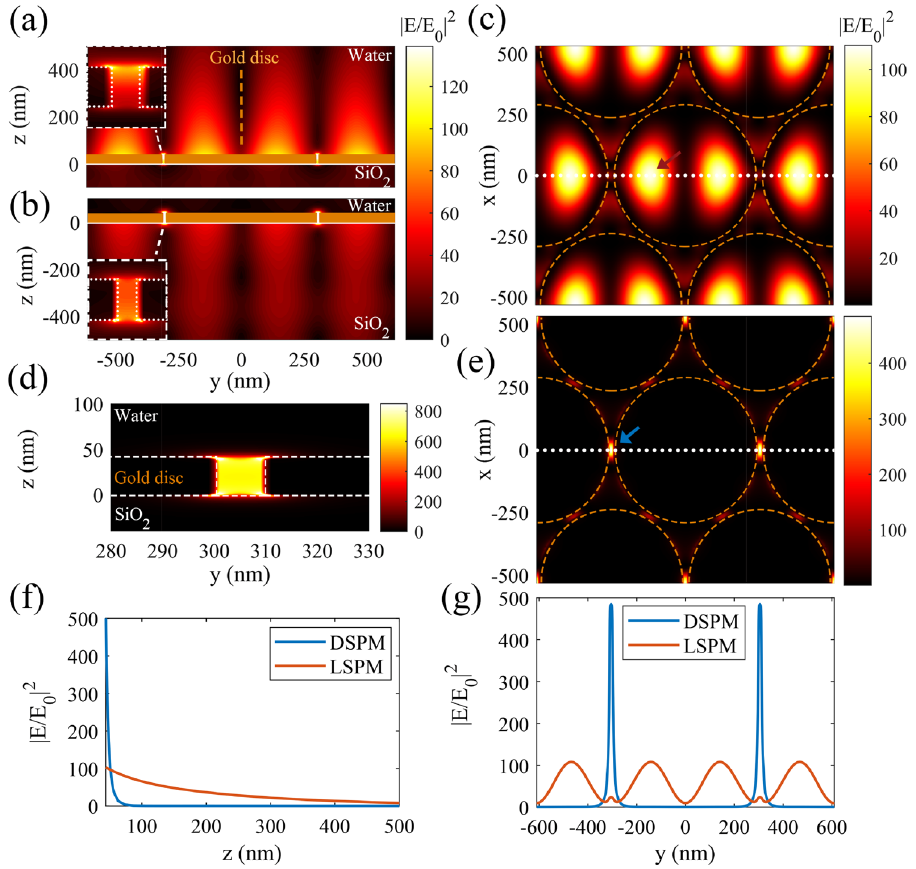
Figure 5. ( a , b ) The cross section views of the field intensity distribution for LSPMs, corresponding to peaks (ii) and (iii) of the red dotted spectrum in Fig. 3b. ( c ) The top view (at z = 50 nm) of the normalized field intensity distribution corresponding to peak (iii) of the red spectrum in Fig. 3b. ( d , e ) The cross section and top views (at z = 50 nm) of the normalized field distribution corresponding to peak (i) of the red dotted spectrum in Fig. 3b. ( f ) Variations of the normalized field intensities of the LSPM and DSPM along the z direction at the x – y position, where the relating field intensities are maximized (shown by the red and blue arrows in ( c , e )). ( g ) Variations of the normalized field intensities of the LSPM and DSPM along the white dashed line in ( c , e ), at z = 50 nm. The orange solid rectangles in parts ( a , b ), and the dashed circles in parts ( c , e ) represent the gold